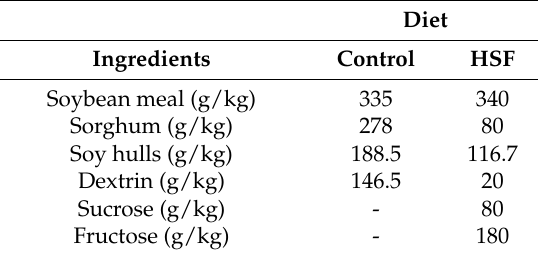
Table 1. Nutritional composition of the